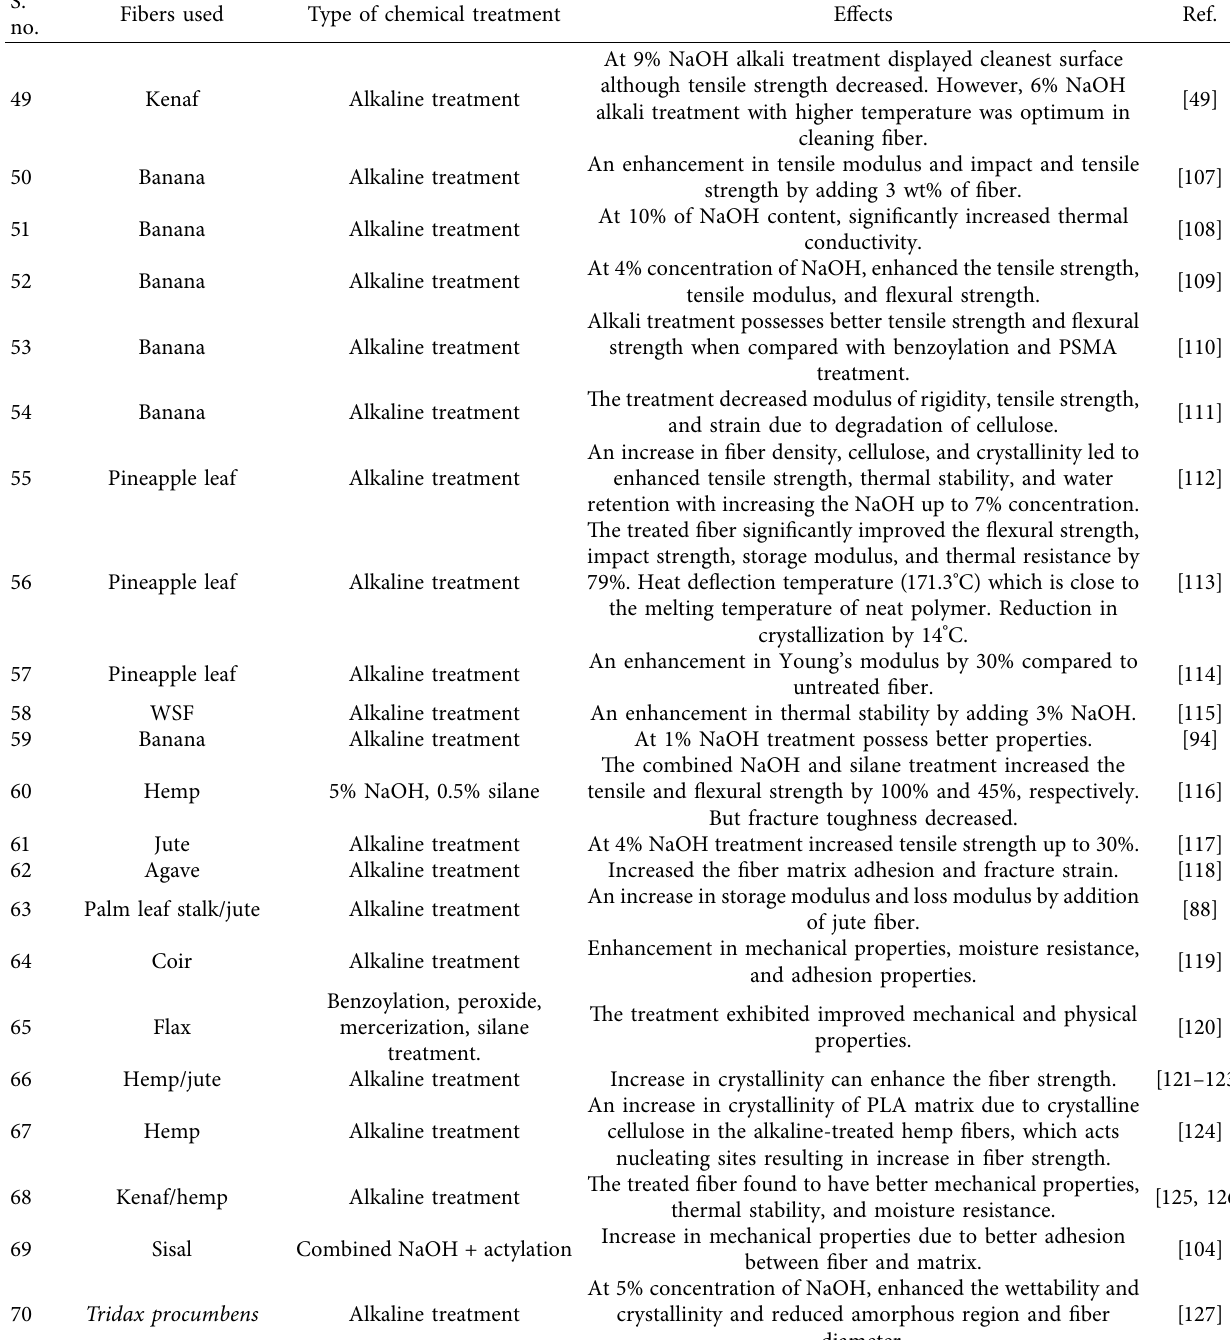
Increased the fiber matrix adhesion and fracture strain. An increase in storage modulus and loss modulus by addition Enhancement in mechanical properties, moisture resistance, The treatment exhibited improved mechanical and physical properties. treatment. Alkaline treatment Increase in crystallinity can enhance the fiber strength. An increase in crystallinity of PLA matrix due to crystalline Alkaline treatment cellulose in the alkaline-treated hemp fibers, which acts nucleating sites resulting in increase in fiber strength. The treated fiber found to have better mechanical properties, Alkaline treatment thermal stability, and moisture resistance. Increase in mechanical properties due to better adhesion Combined NaOH + actylation between fiber and matrix. At 5% concentration of NaOH, enhanced the wettability and Alkaline treatment crystallinity and reduced amorphous region and fiber Figure 2 represents the SEM images of untreated and treated Prosopis juliflora fiber-reinforced epoxy composites at different concentrations (5%, 10%, and 15%). Figure 2(a) shows the untreated fiber surface which consists of impu- rities and fiber pull-outs on the surface. This was due to the waxy substances present on the surface of the fiber and the existence of hydroxyl groups, which leads to water ab- sorption, weakening interfacial strength with the matrix.